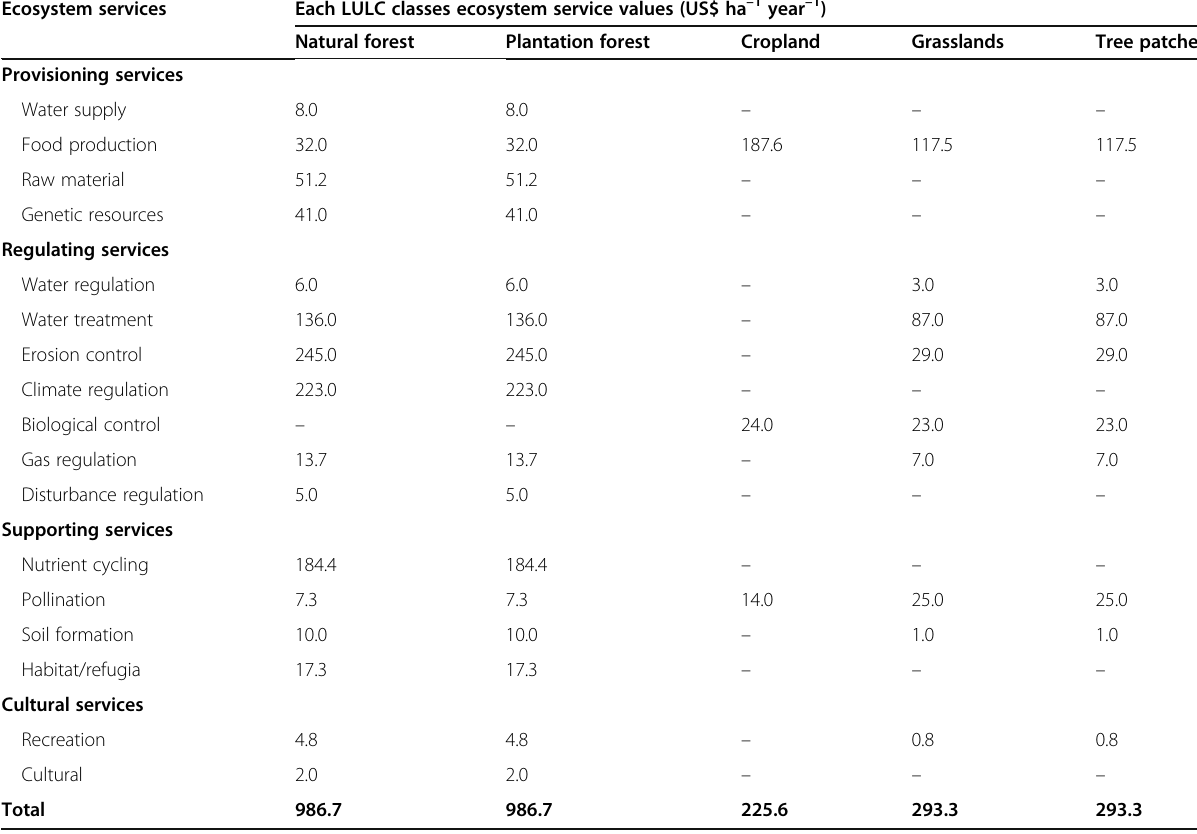
Table 2 Individual ecosystem service value coefficients (US $ ha – 1 year – 1 ) for the five representative biomes based on the modified estimates of Kindu et al.